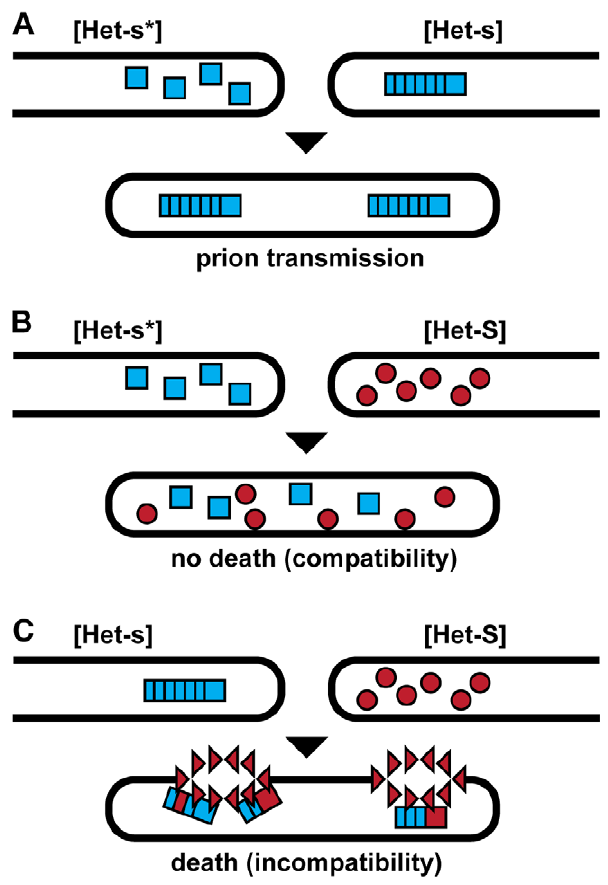
Figure 2. The P. anserina Het-s/Het-S locus mediates hetero- karyon incompatibility. When two P. anserina mycelia fuse to form a heterokaryon, the Het-s/Het-S heterokaryon incompatibility system dictates whether the heterokaryon will be viable. The P. anserina Het-s locus has two alleles, Het-s and Het-S , meaning that a given mycelium expresses either the Het-s or Het-S protein. The Het-s protein generally adopts a prion structure and this form of Het-s is denoted [Het-s], whereas the soluble form is denoted [Het-s*]. Thus, there are three possible combinations of Het-s with Het-S. (A) A [Het-s*] strain can fuse with a [Het-s] strain to produce a viable heterokaryon in which the prion phenotype, [Het-s], is transmitted. (B) A [Het-s*] strain can fuse with a [Het-S] strain to produce a viable heterokaryon. (C) A [Het-s] strain can fuse with a [Het-S] strain to produce a nonviable heterokaryon. Het-s amyloid induced Het-S amyloid formation (indicat- ed by red squares) leads to a conformational change in the Het-S HeLo domain that triggers intermolecular Het-S pore formation (indicated by red triangles).